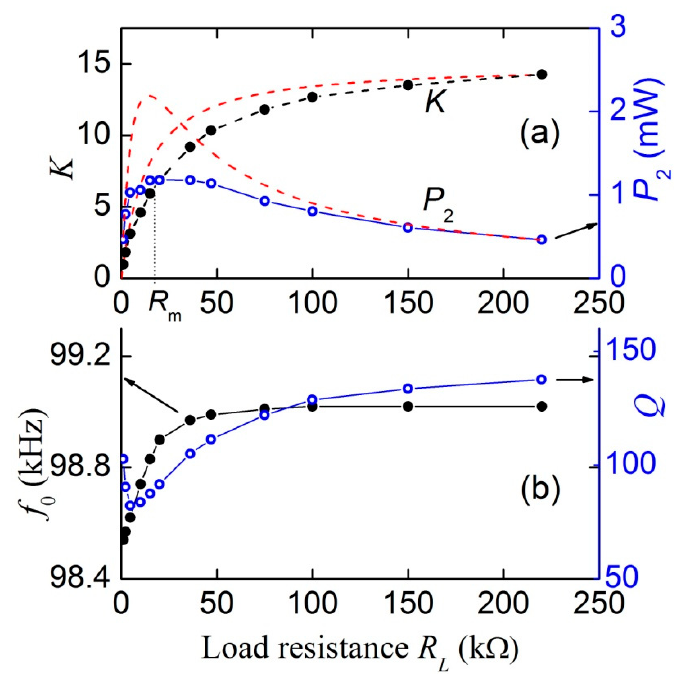
Figure 6. Dependences of ( a ) the voltage transformation ratio K and the output power P 2 on the load resistance R L and ( b ) the resonance frequency f 0 and the quality factor Q on the load resistance R L at H = 6.37 kA/m. The dashed lines in ( a ) are the calculated dependences. Solid lines are drawn to guide the eye. R m is the load resistance for the maximum output power.